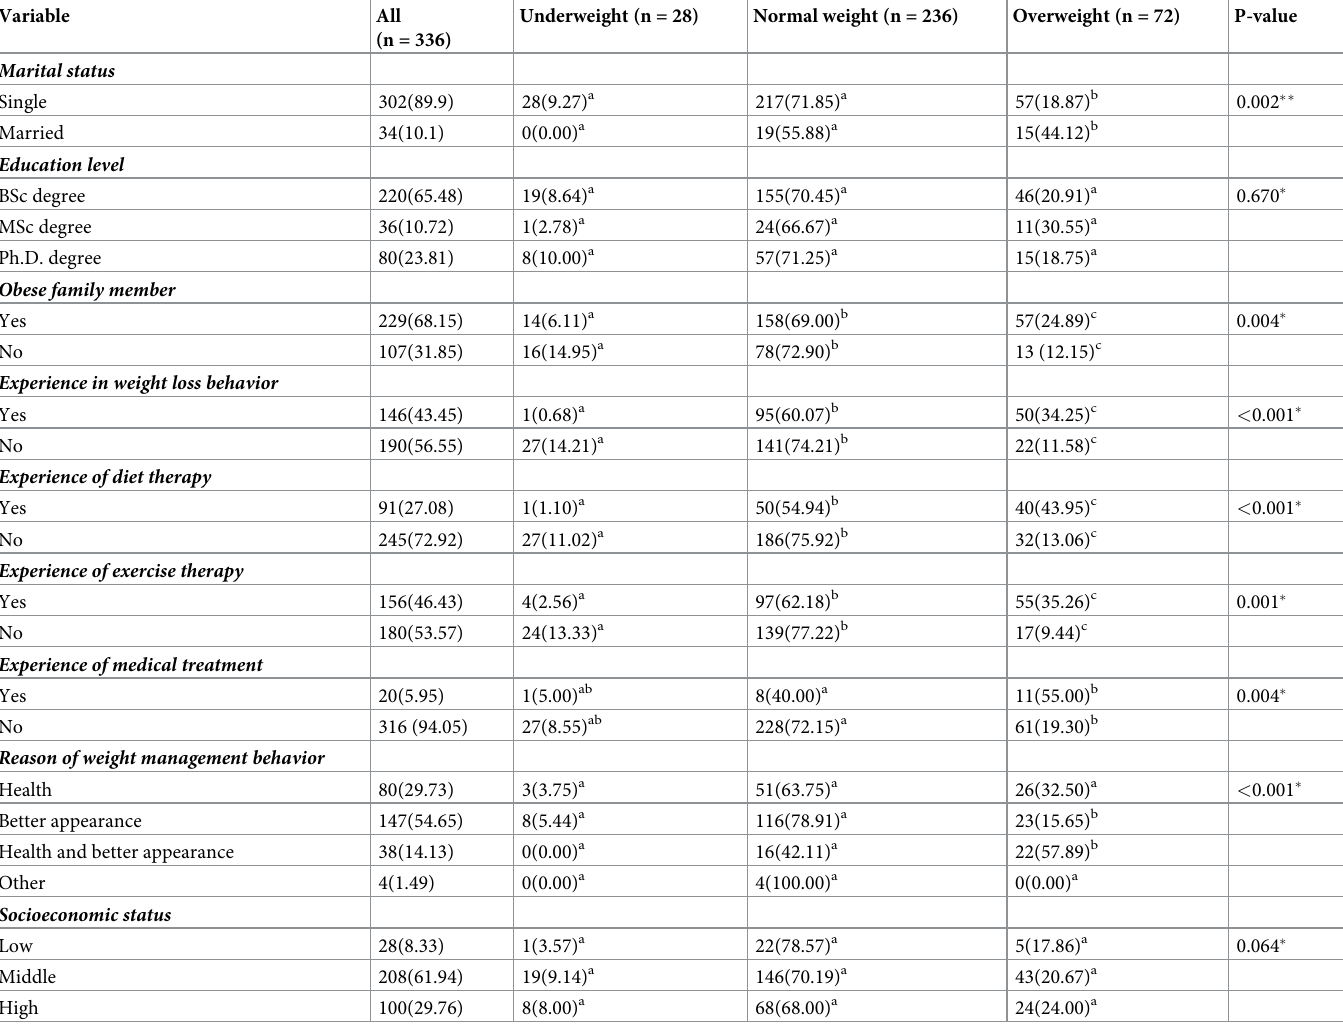
Table 1. Baseline characteristics of the study